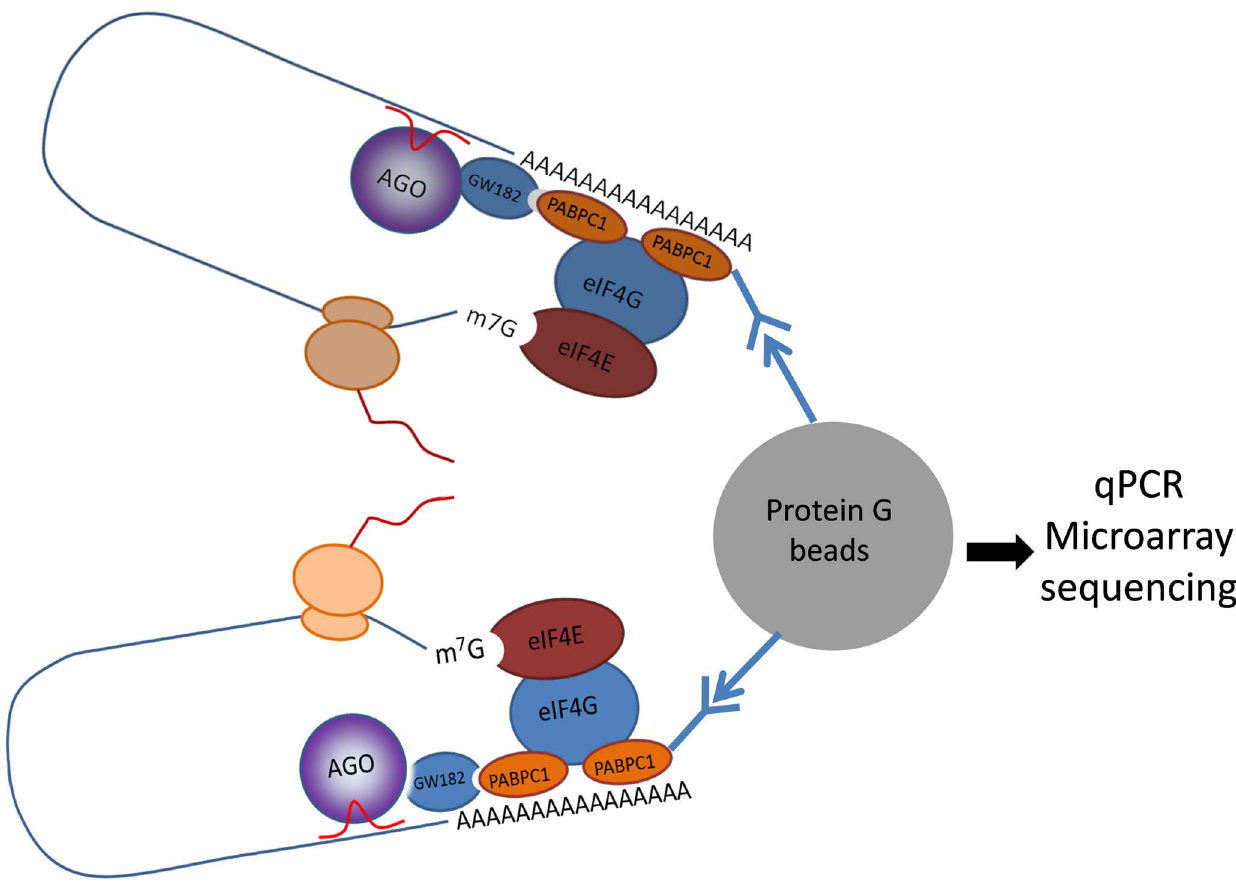
Figure 1. Schematic presentation of RNP immunoprecipitation. PABPC1 participates in the process of post-transcriptional regulation of gene expression by miRNA. Therefore, we used anti-PABPC1 to identify the miRNAs that target EED mRNA.